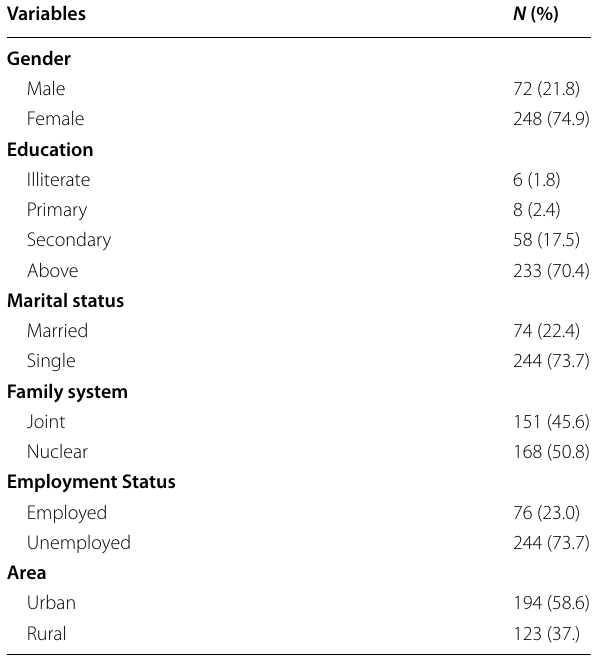
Table 1 Socio demographics of the sample ( N